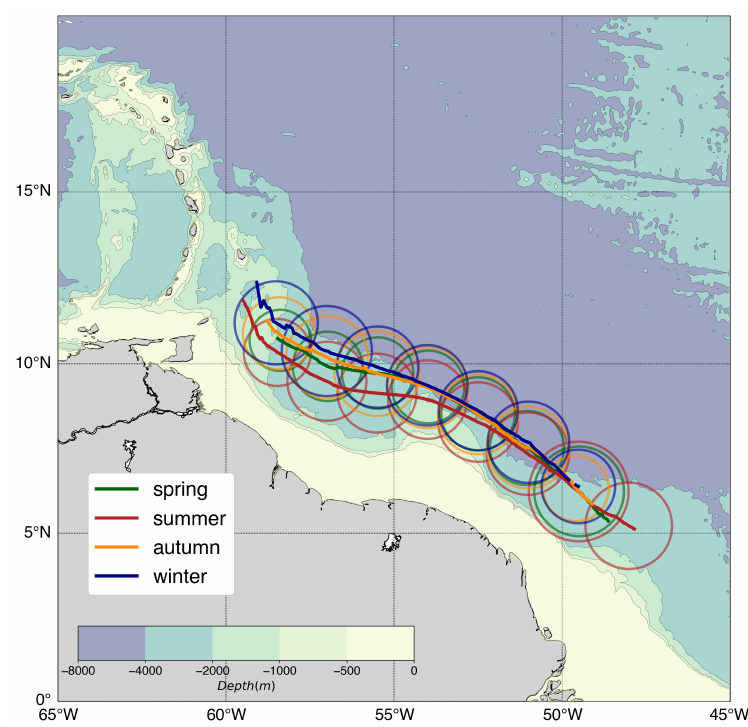
Figure 14. Mean NBC rings trajectories seasonality and estimated contours based on the average radius for each different season (considering rings as circles). Green, red, orange, and blue respectively correspond to rings generated in spring, summer, autumn and